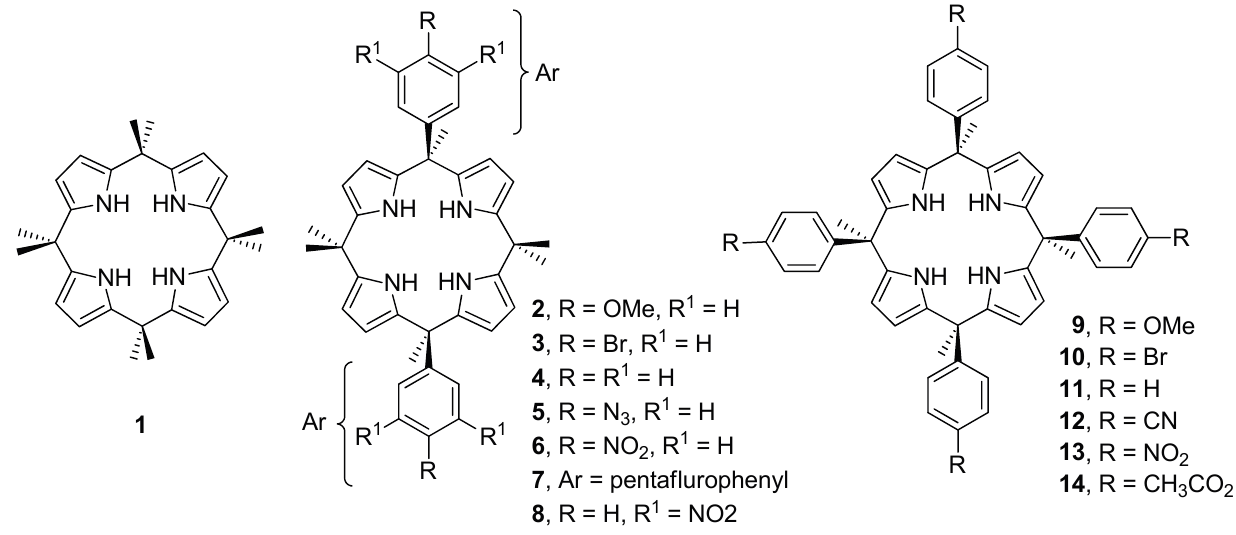
Figure 1. Molecular structures of receptors 1 – 14 studied in this